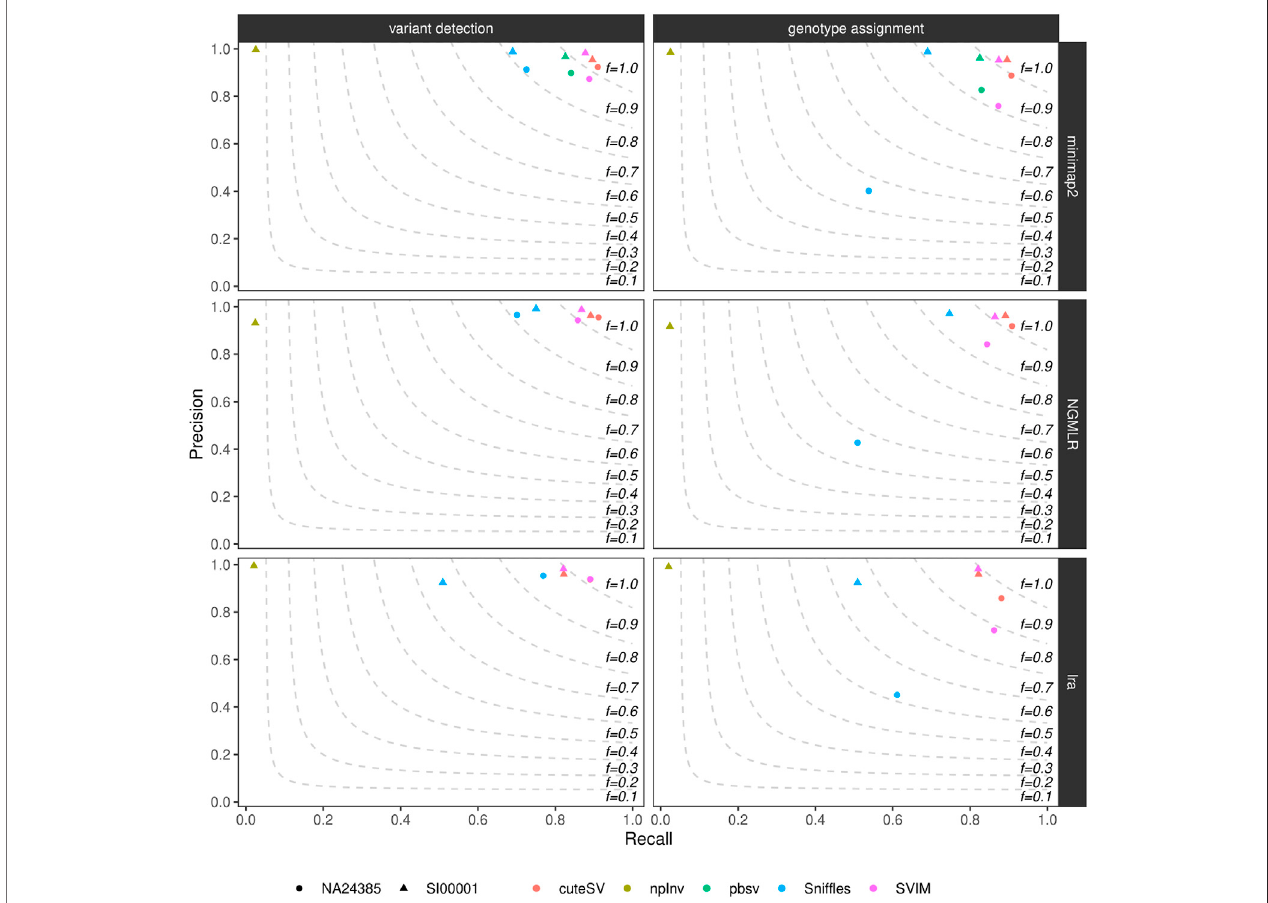
FIGURE1| Precision(yaxis), recall (x axis)and F-score (dashed lines) ofthehigh-qualitySVcallsets from Snif fl es, SVIM,cuteSV,npInv and pbsv (huepalette)after minimap2 (top panels), NGMLR (mid panels) and lra (bottom panels) alignments. Results for both SV calling (left panels) and genotyping (right panels) in the NA24385 (circle symbol) and SI00001 (triangle symbol) datasets are